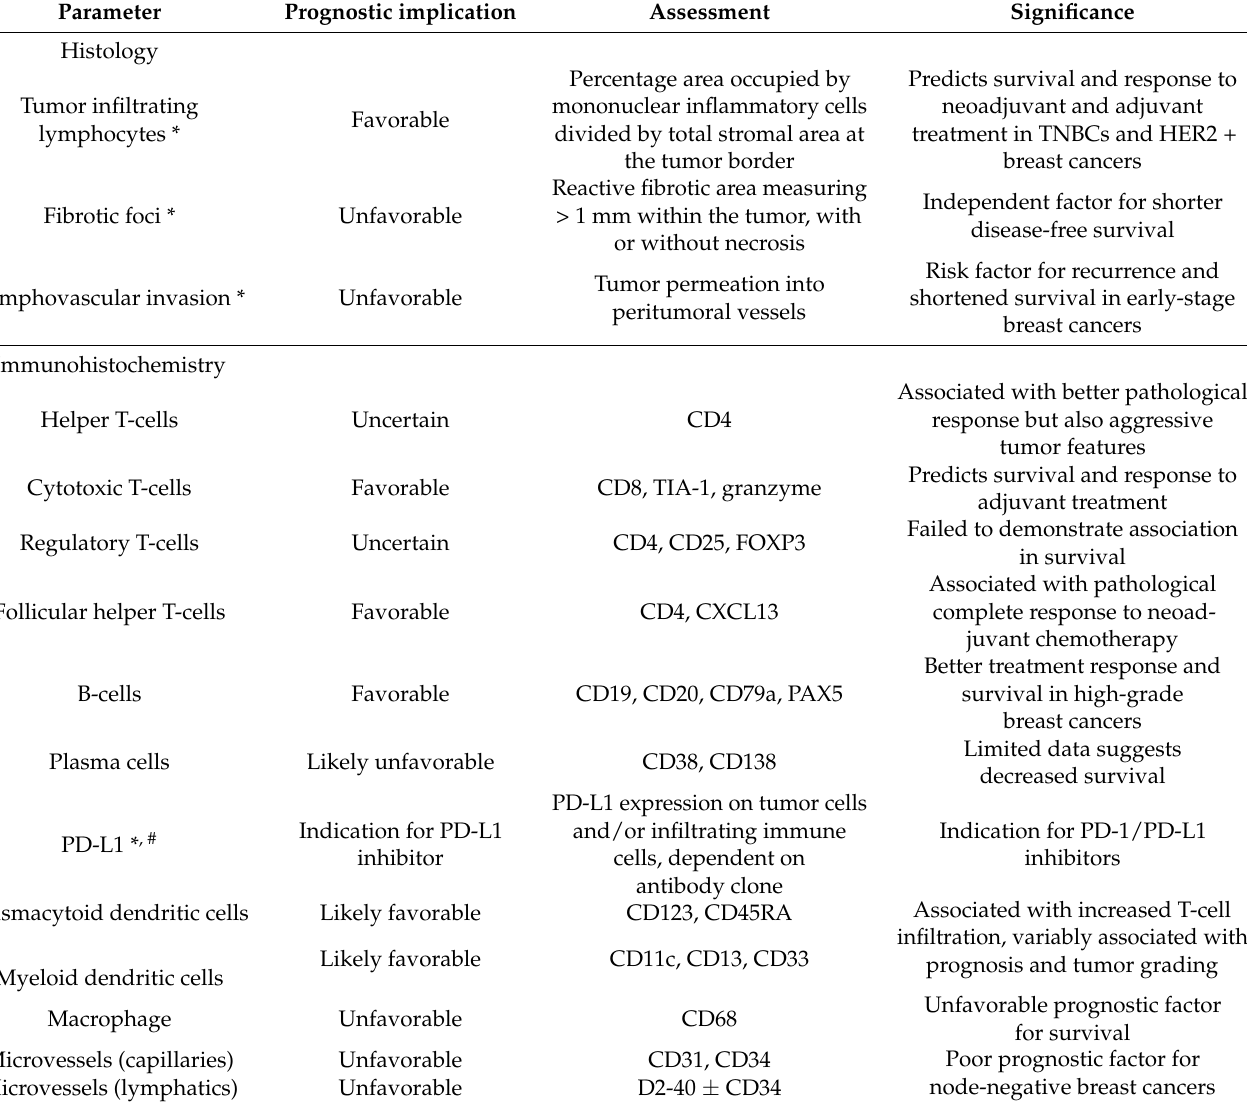
Table 2. Prognostic pathological